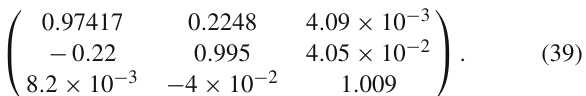
Fig. 6. The solid and dashed line denote two loop and one loop predictions respectively. Figure 6a shows that, the rela- tive corrections from two loop diagrams to one loop correc- ¯ B → X s γ ) can reach around 3%, which pro- tions of Br ( ¯ B → X s γ , duces a more precise prediction on the process and we cannot neglect the corrections with this